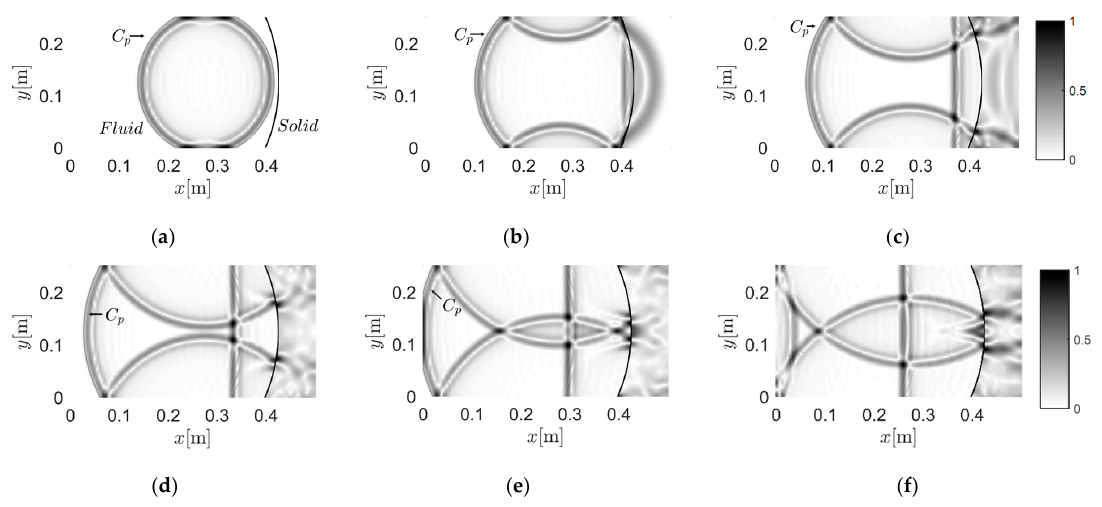
Figure 7. Snapshots of the wavefield induced by the source at 0.275 m and 0.125 m in the fluid